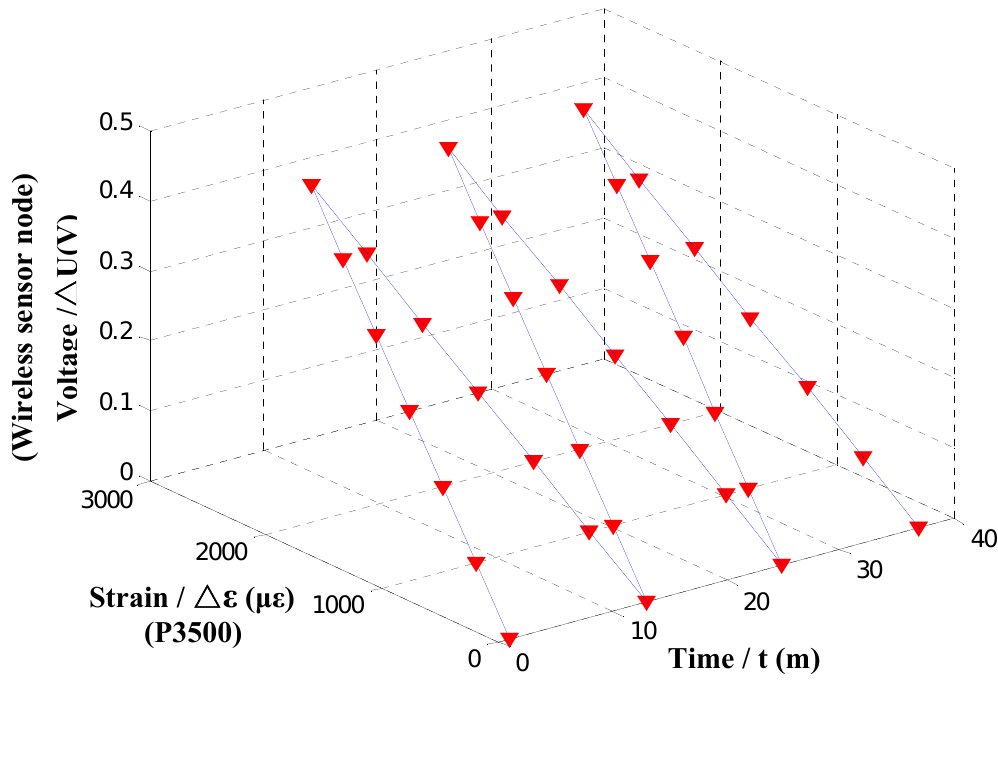
Figure 5. The wireless sensor node output voltage VS. P3500 strain readings with 1 minute increments.